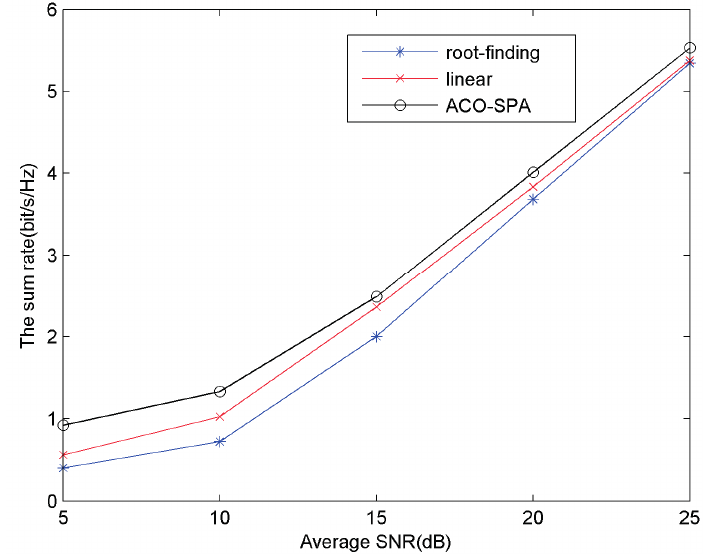
Figure 7. The sum rate versus average